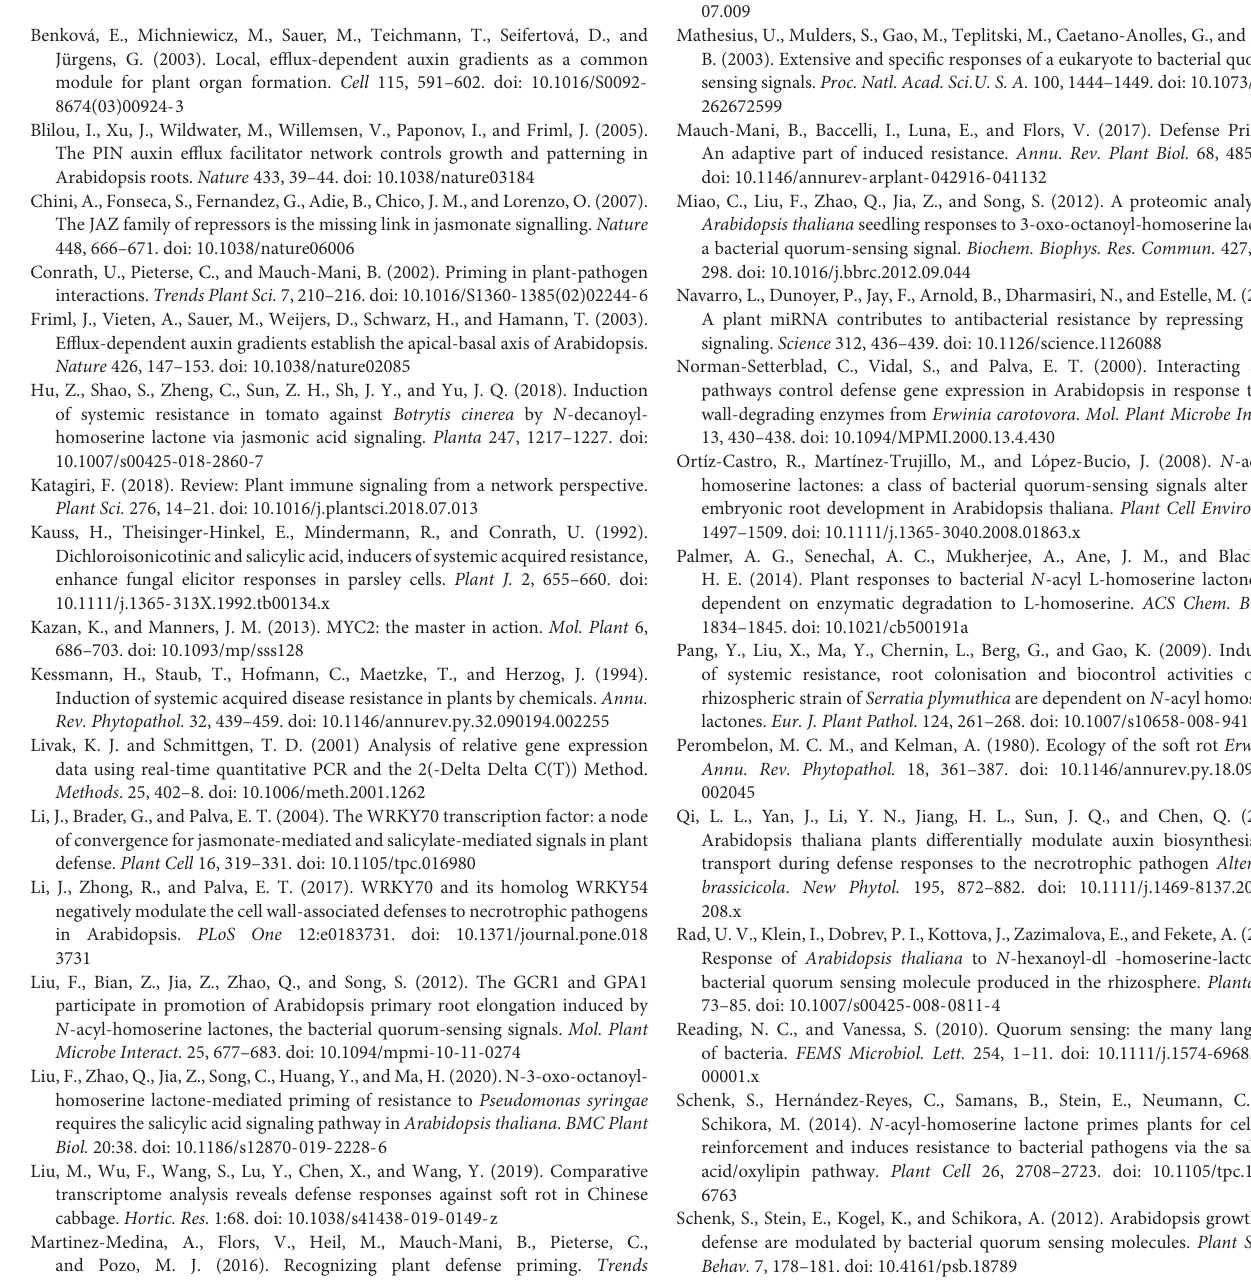
Supplementary Figure 2 | Effects of 3OC8-HSL application on the accumulation of JA-Ile. Accumulation of JA-Ile was measured by ELISA in Arabidopsis plants in which the roots were pretreated with 10 µ M 3OC8-HSL for 48 h and the leaves